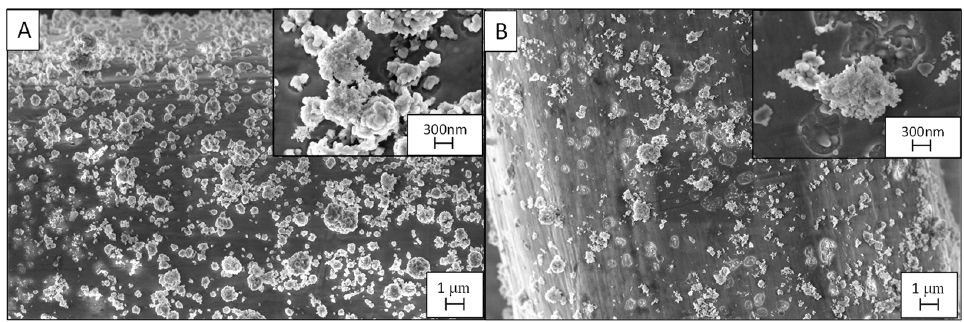
Figure 8. SEM micrographs of PD3m-P coating before ( A ) and after ( B ) the five use cycles; the images were acquired at 10kx magnification, and the insets were acquired at 50kx.